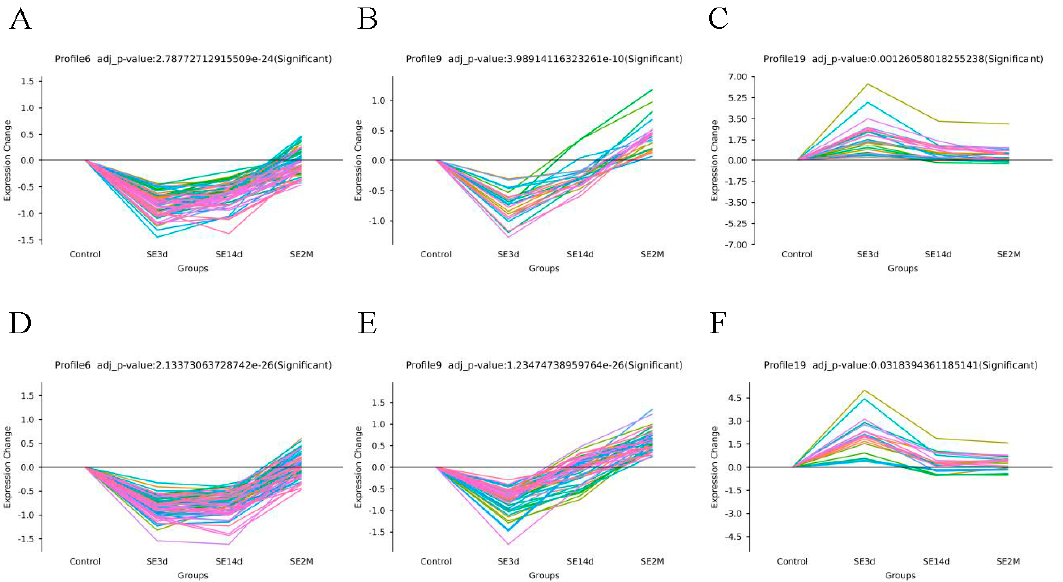
Figure 2. CA ( A – C ) and DG ( D – F ) area of significant gene expression trends. The abscissa represents different time points, the ordinate represents the grading of gene changes, and each line represents a different miRNA. It can be concluded that trends of No.6 (A/D), 9 (B/E) and 19 (C/F) have significant differences in both CA and DG areas among the 26 trends generated. Table 3. Numbers of predicted intersecting target genes of changed